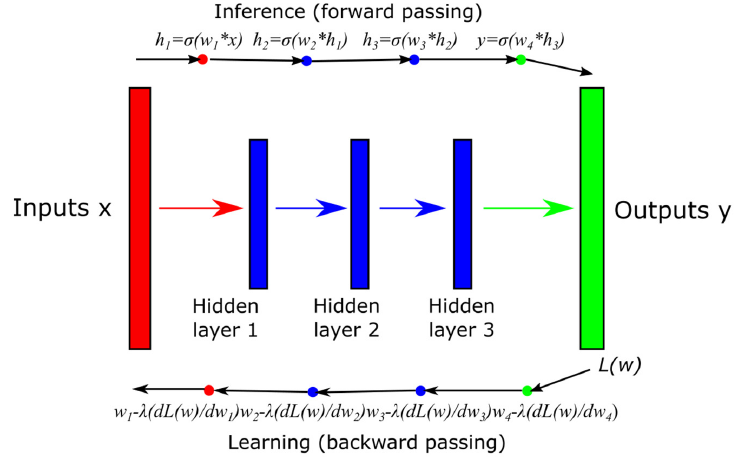
Figure 14. Learning principle of a neural network (based on